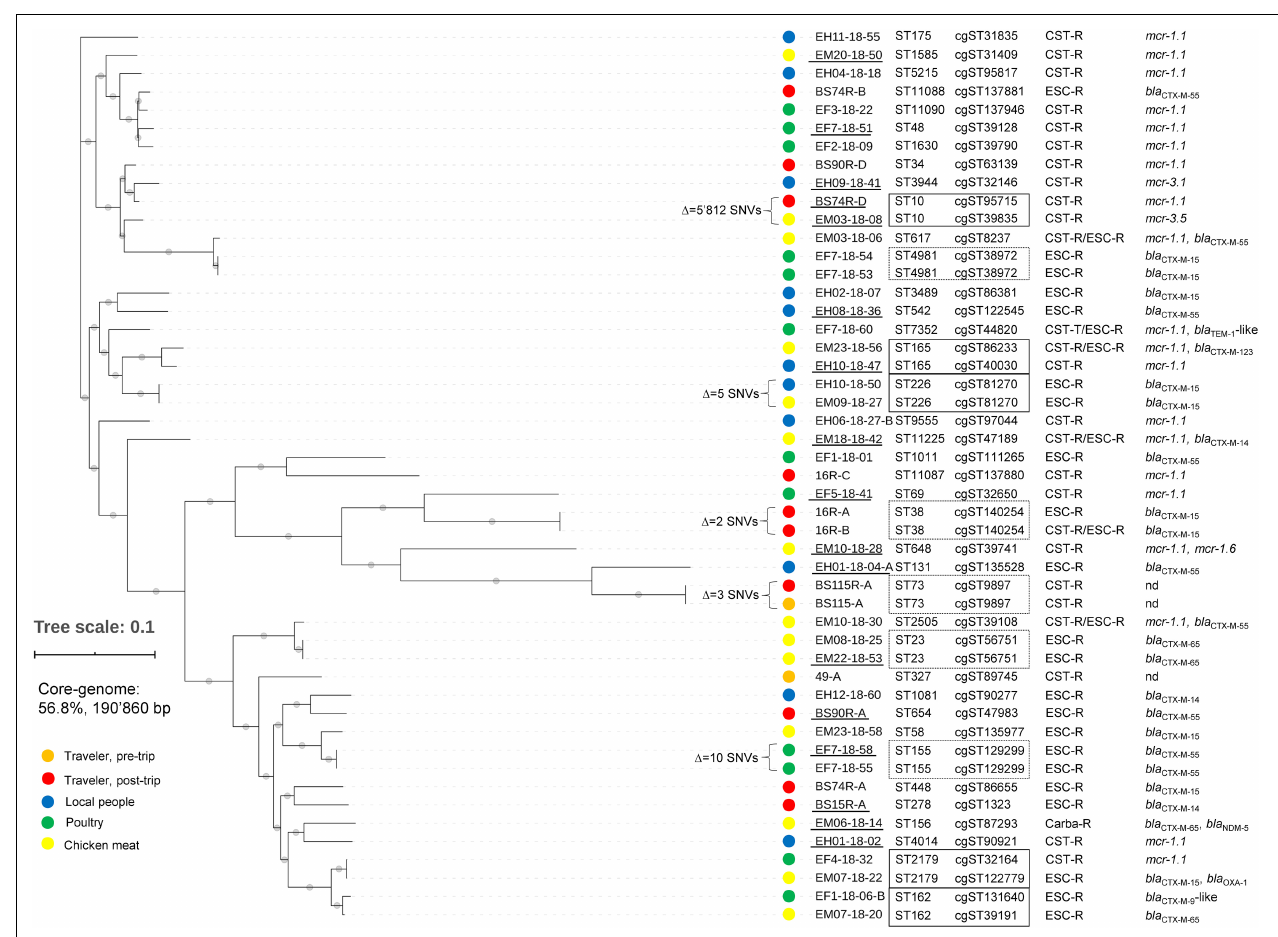
FIGURE 2 | Results of the core-genome analysis for the 49 E. coli ( Ec ) strains isolated from travelers and local sources in Laos. The core-genome analysis of the assembled WGS of the strains is presented in a SNVs hierarchical clustering dendrogram tree. The (cid:49) SNV values correspond to the number of non-identical SNVs between two strains. The SNV tree was visualized with iTOL (https://itol.embl.de). The filled colored circles on the left of the strain names indicate the different isolation sources: orange, red, blue, green, and yellow for traveler pre-trip, traveler post-trip, local people, poultry, and chicken meat, respectively. For each strain we also show the sequence type (ST), core-genome ST (cgST), and main resistance gene(s). CST-R: colistin-resistant, ESC-R: extended-spectrum cephalosporin-resistant, Carba-R: carbapenem-resistant, nd: not detected. Strain names that are underlined represent isolates for which the complete chromosome and plasmid sequences were obtained by a hybrid sequencing approach. Strains sharing the same ST are indicated with a dotted rectangle; those that were from different settings were indicated with a full rectangle.